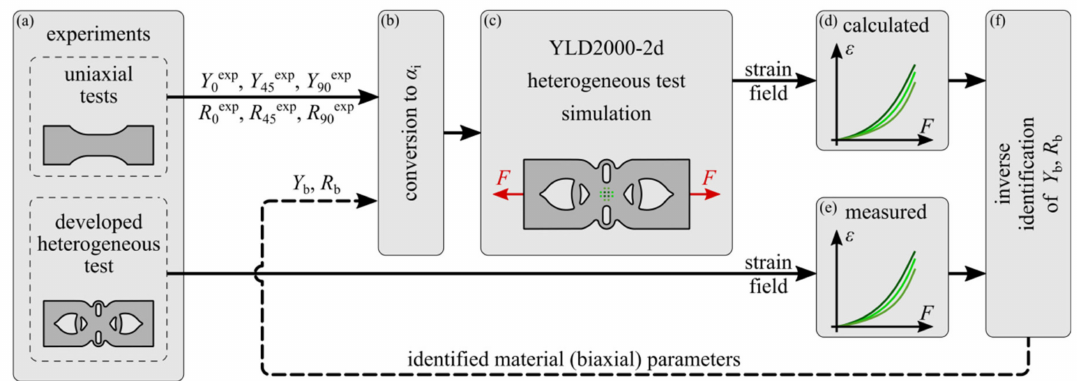
Figure 1. Proposed calibration procedure using standard uniaxial tensile tests and purposely developed heterogeneous test: ( a ) required experimental tests, ( b ) conversion of parameters Y 0 , Y 90 , Y 45 , R 0 , R 90 , R 45 , Y B , R B to YLD2000-2d parameters α 1 , α 2 , ... , α 8 , ( c ) numerical simulation of heterogeneous test